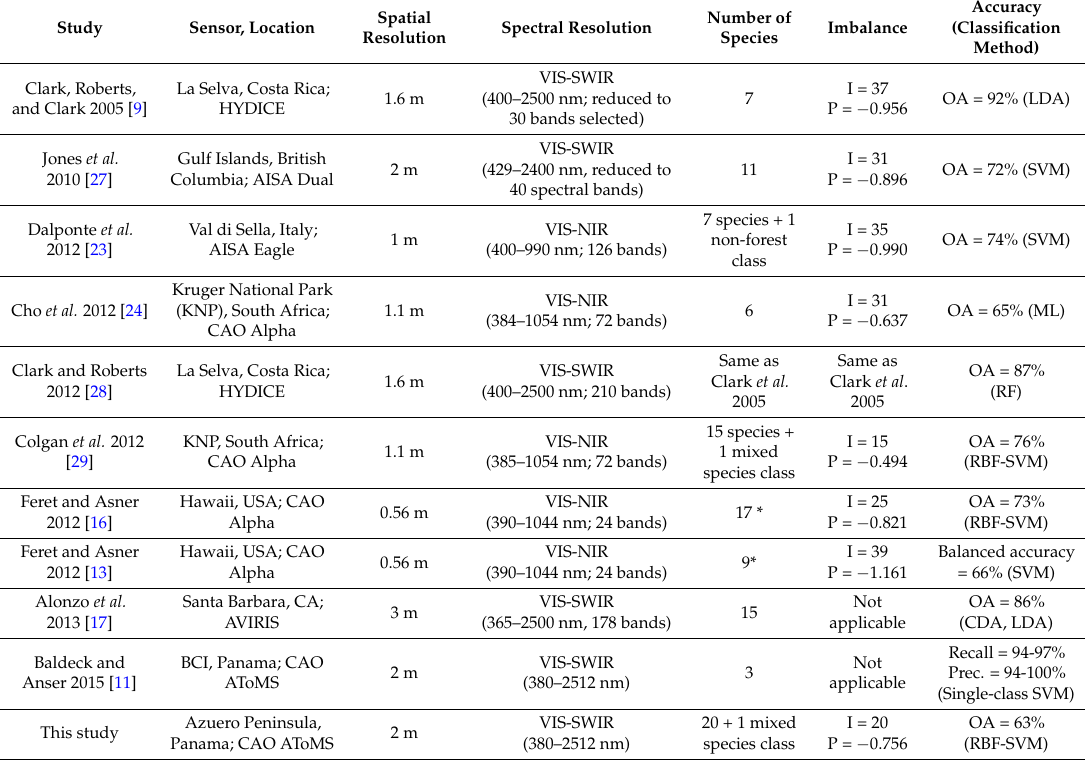
Table 1. Summary of species classifications using imaging spectroscopy to classify 3 or more species in temperate and tropical forests. Studies using spectral mixture analysis were not included. Imbalance is calculated as the exponential decay of a species rank abundance curve with the sample size for each class/species. The intercept (I) represents the relative abundance of the largest class and the power (P) represents the degree of imbalance (See Figure